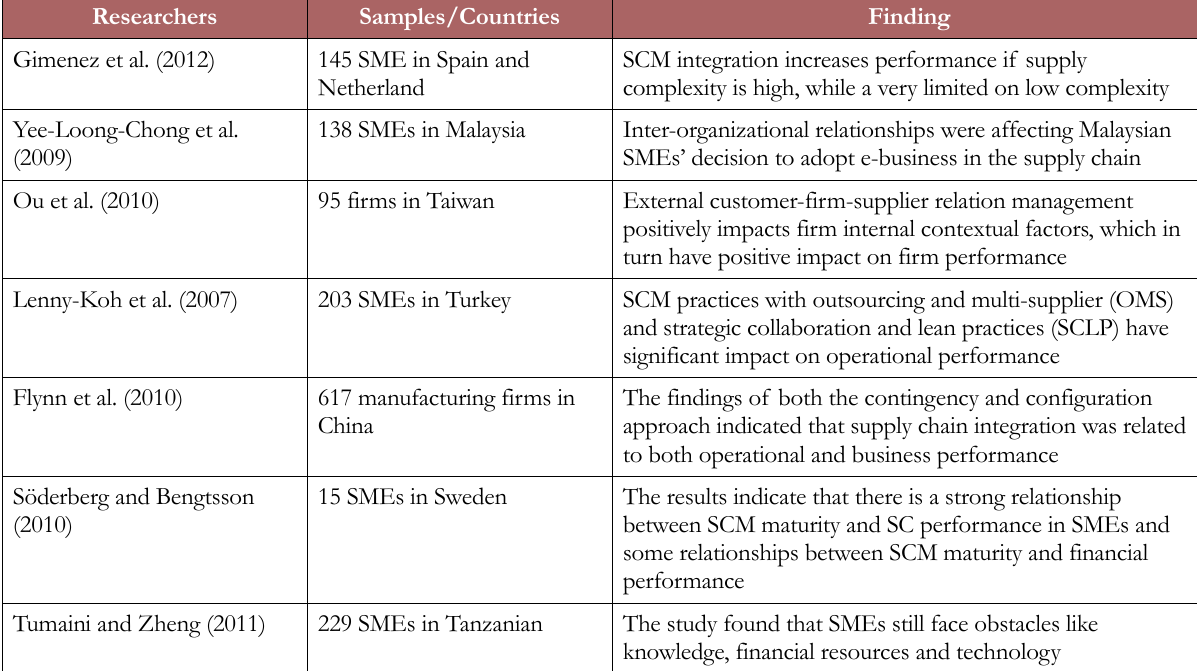
Table 1. Previous finding in different